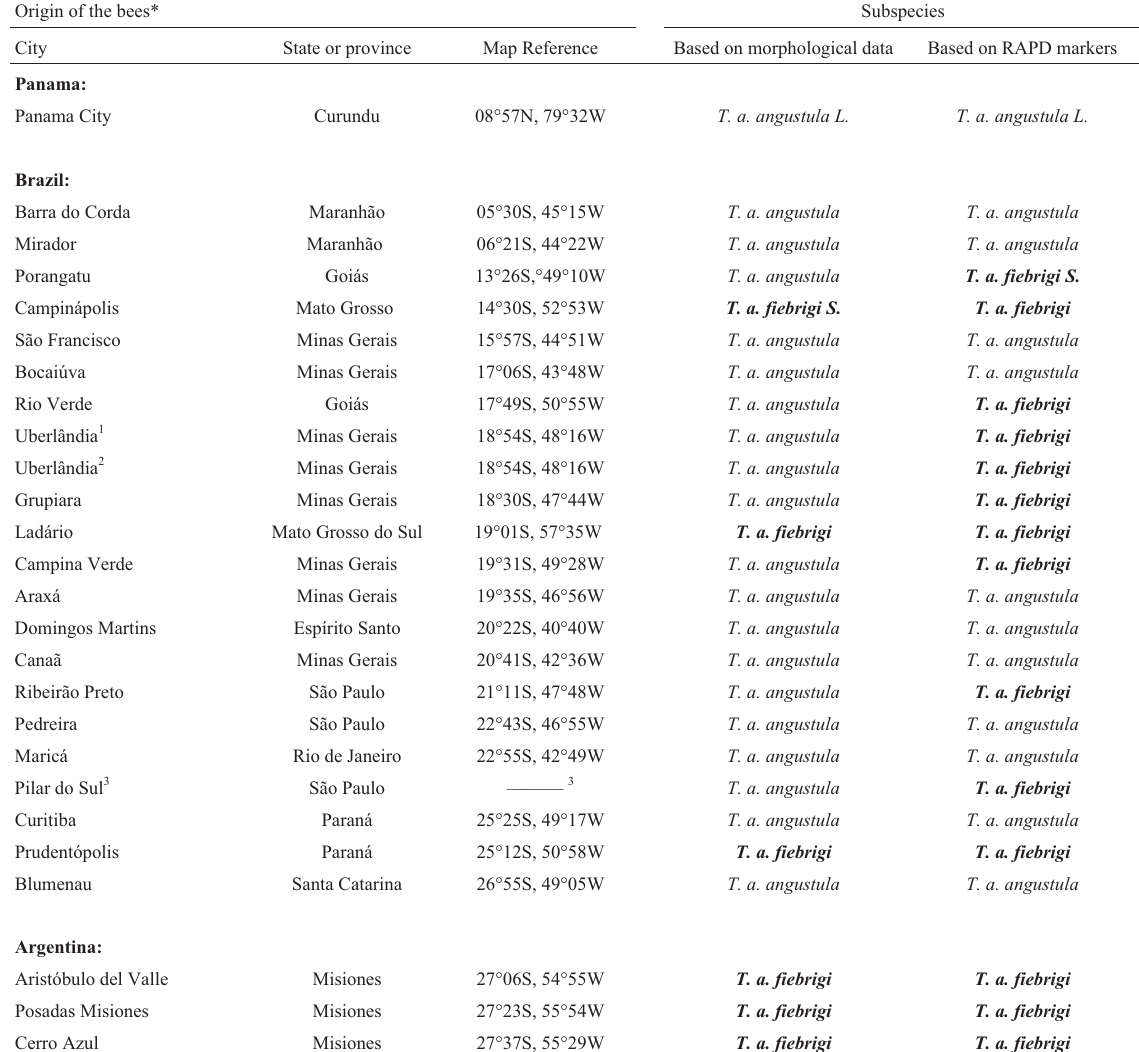
Table 1 - Origin of the Tetragonisca angustula specimens studied and their identification based on the morphological characteristics given by Nogueira Neto (1970) as compared with RAPD markers. Origin of the bees* Subspecies State or province Map Reference Based on morphological data Based on RAPD